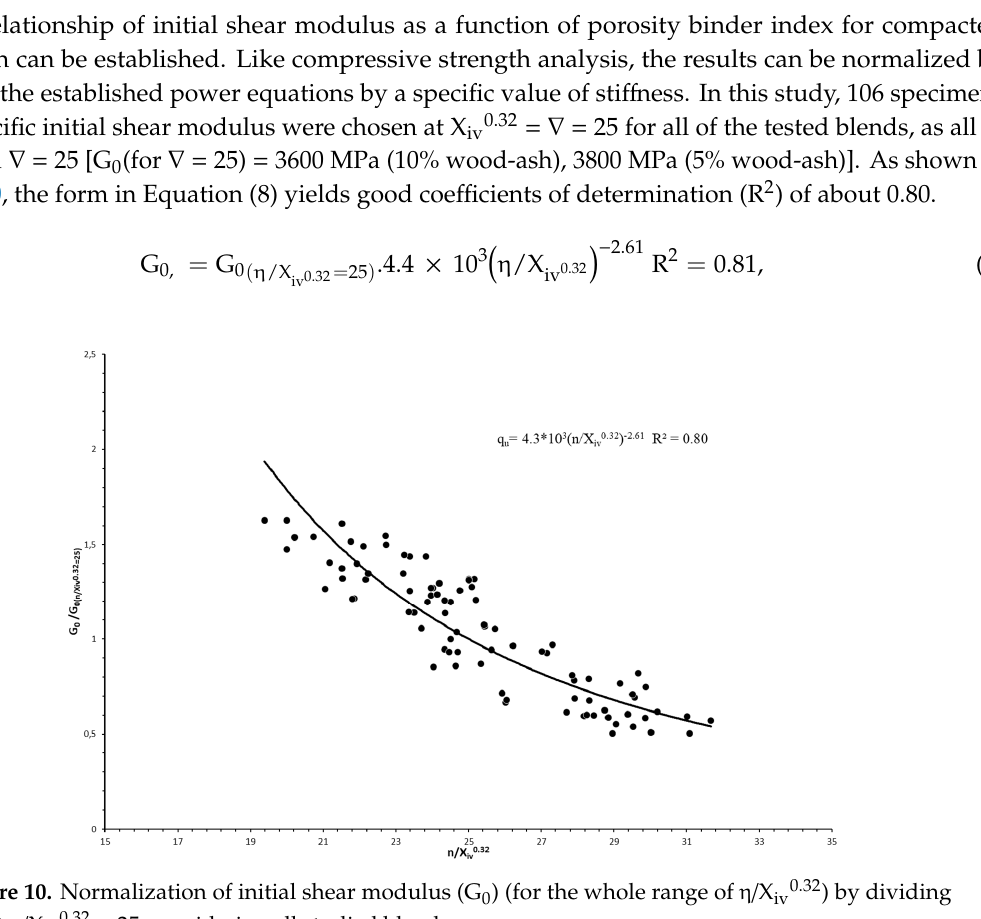
Figure 9. Variation of initial shear modulus (G 0 ) with adjusted porosity/binder index for all blends, considering cement + 5% wood-ash and cement + 10% wood-ash.